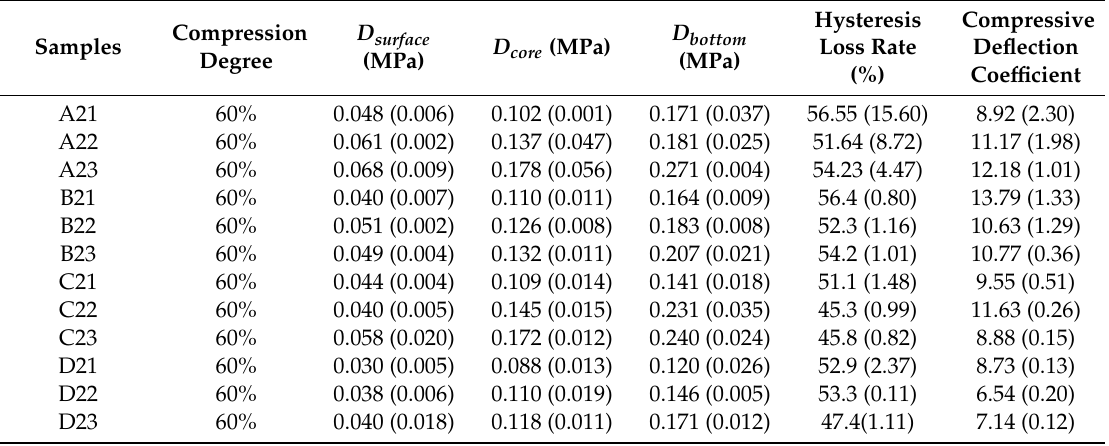
Table 4. The mechanical properties of mattresses of untreated and treated columned lu ff a that were hot-pressed to initial densification